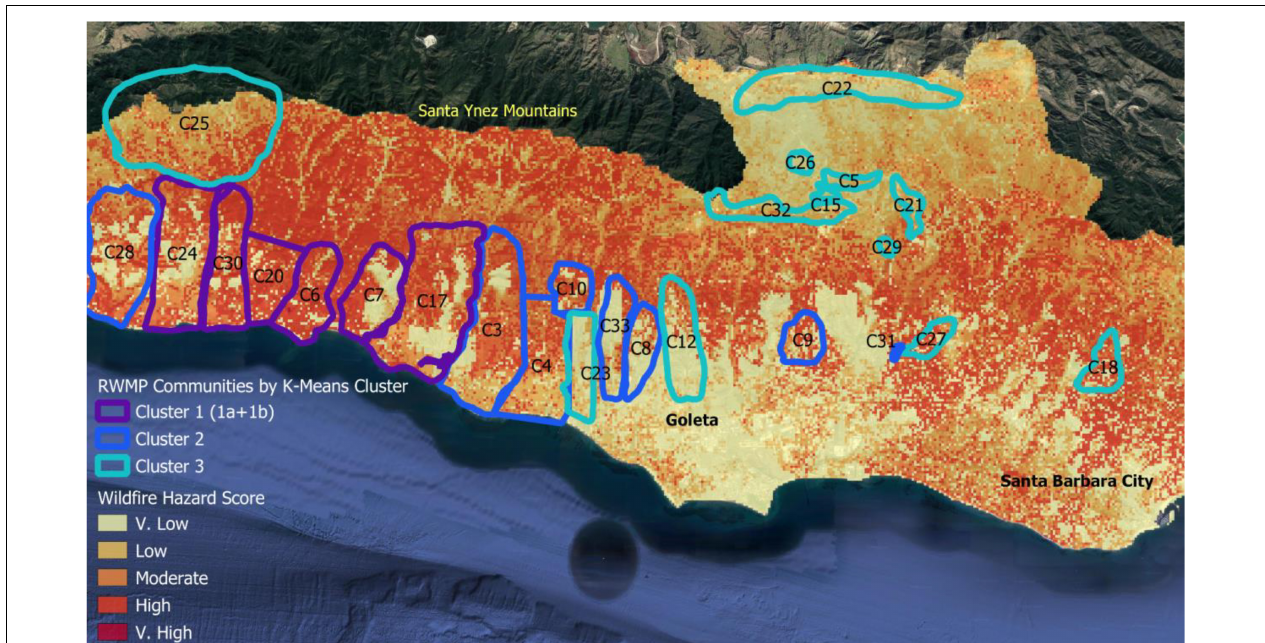
FIGURE 10 | Wildfire hazard map and community areas of the Santa Barbara RWMP region. Map is a subset of the total RWMP project area. The yellow–red color scale indicates wildfire hazards according to quantile at 90 m pixel areas. RWMP community areas are drawn with colored outlines showing their designation to three groups of general wildfire hazard, vegetation conditions, and structure adaptation levels, identified by K -means cluster analyses of field survey and satellite data (see Supplementary Table 2 and Supplementary Figure 1 ).